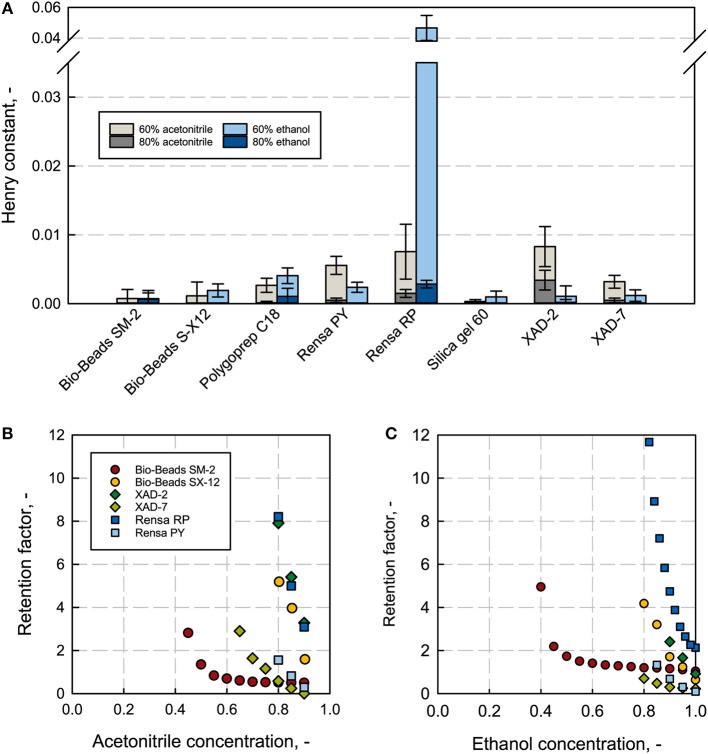
Henry constants from batch adsorption experiments at an initial concentration of 0.1 g L−1 β-caryophyllene (A) for all investigated adsorbents at different ethanol (blue) and acetonitrile (gray) concentrations. Rensa® RP shows the highest Henry constant with 60% ethanol. Retention factors for different adsorbents with β-caryophyllene (B,C) subject to the solvent concentration of ethanol and acetonitrile show extreme variances in the affinity.